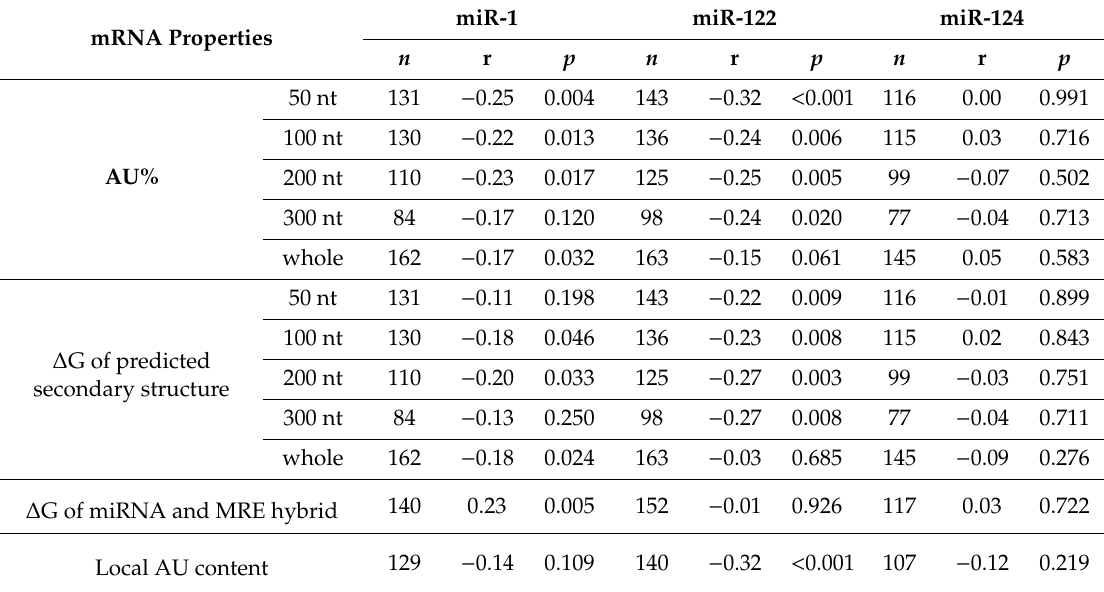
Table 2. Correlations between R1 values and mRNA